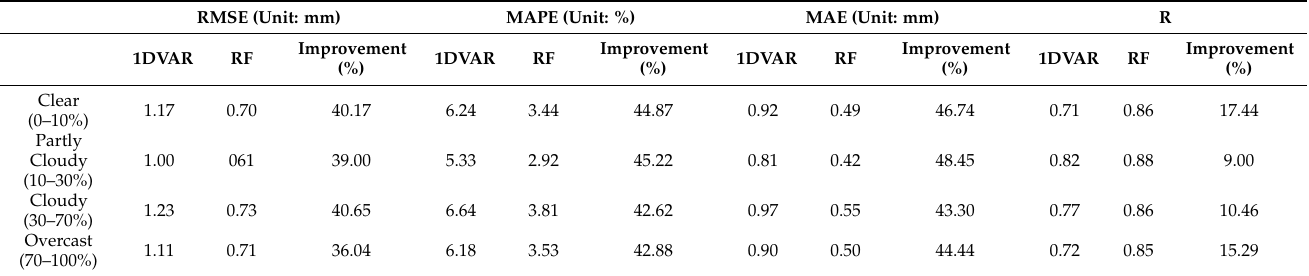
Table 6. Retrieval accuracies between 1DVAR and RF-based methods for different cloudy